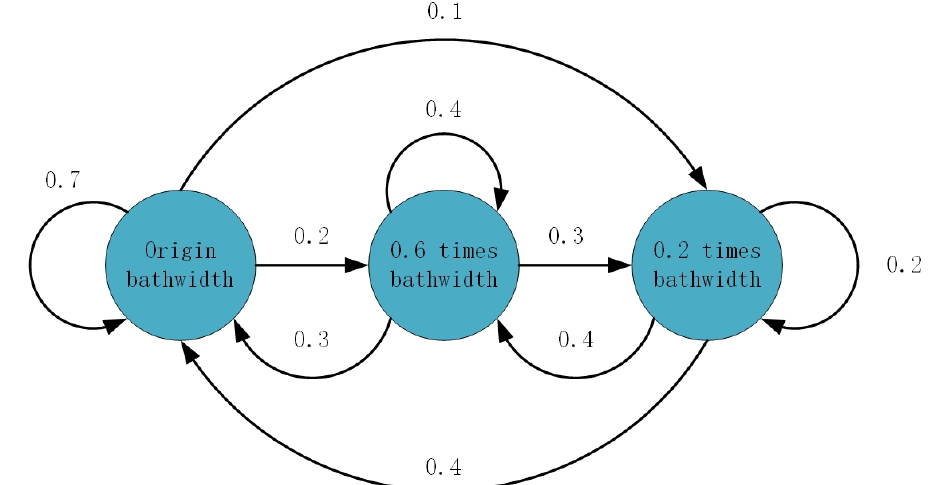
Figure 2. The transition probability between three bandwidth status, where the origin state remains unchanged with a probability of 0.7, transitions to the 0.6 times bandwidth status state with a proba- bility of 0.2, then transitions to the 0.2 times bandwidth status with a probability of 0.1. The 0.6 times bandwidth state remains unchanged with a probability of 0.4, transitions to the 0.2 times bandwidth status state with a probability of 0.3, and then transitions to the origin bandwidth status with a proba- bility of 0.3. The 0.2 times bandwidth state remains unchanged with a probability of 0.2, and then transitions to the 0.6 times bandwidth status state with a probability of 0.4, and then transitions to the origin bandwidth status with a probability of